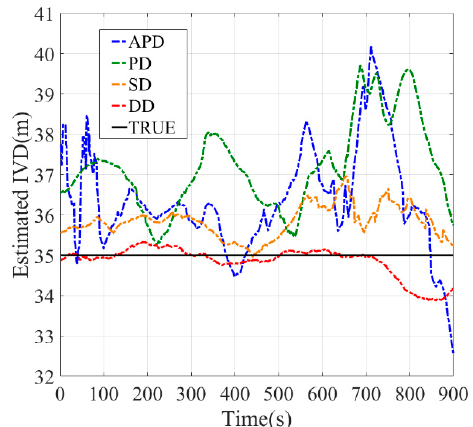
Figure 14. Baseline = 35 m.